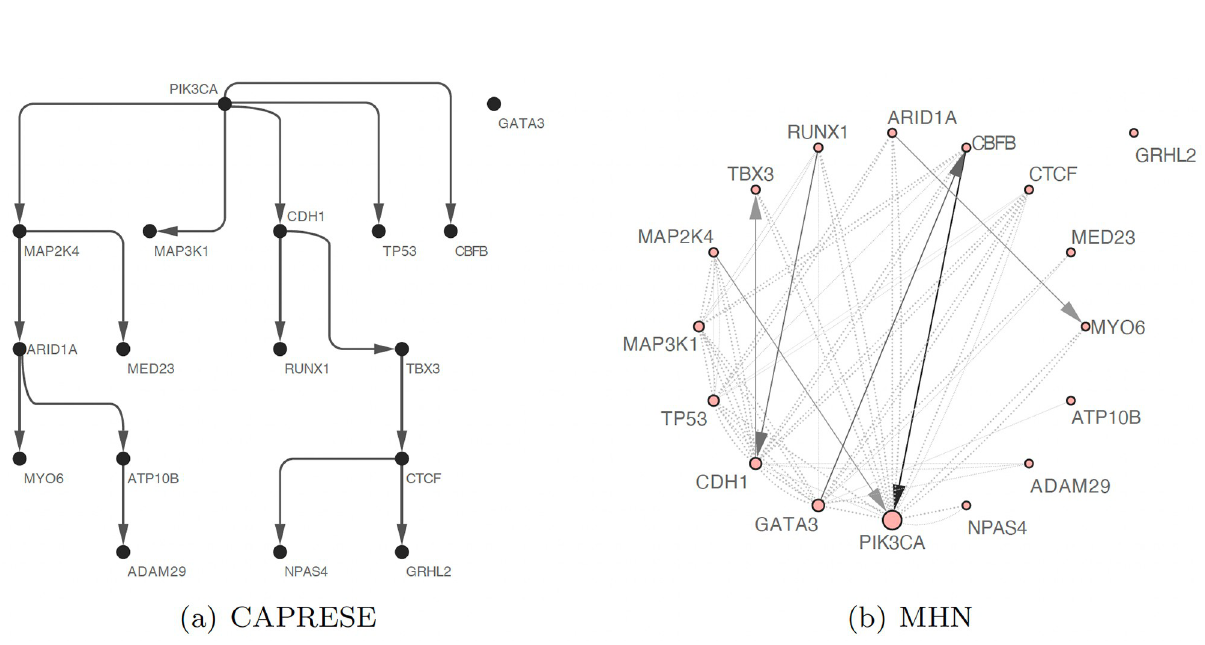
Fig 6. The oncogenetic tree inferred by CAPRESE is shown in subfigure (a) Its edges and nodes are shown in uniform width and size. The Oncogenetic graph inferred by MHN is shown in subfigure (b). Its edge widths and shade are linear to the exponential of inter-event hazard rates. Node sizes are linear to the exponential of spontaneous hazard rates. Solid lines represent edges with positive weights, and dashed lines represent negative ones.